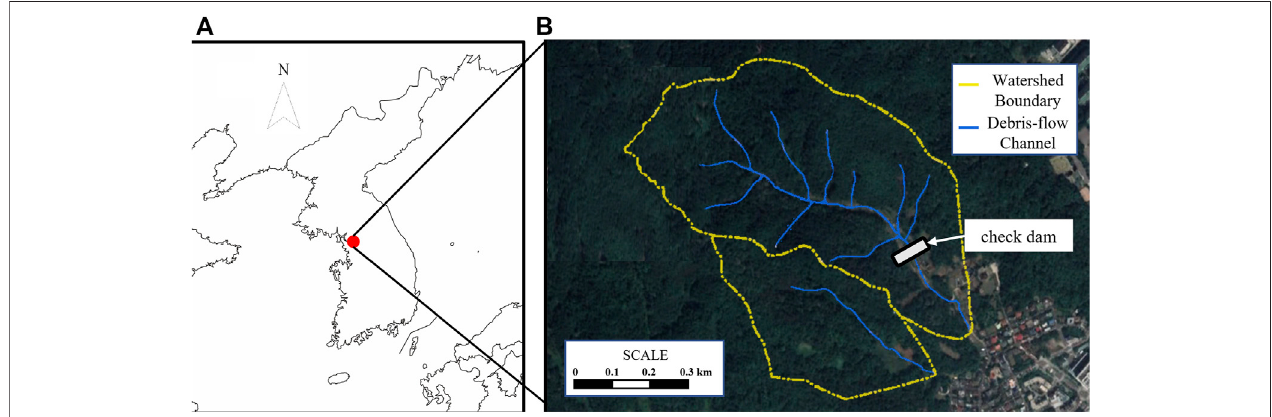
FIGURE 1 | (A) Location of the Hyoungchon watershed. (B) Boundary (yellow line) and debris fl ow channel (blue line) network of the watershed. The gray block in the downstream region is the check dam analyzed in this study.